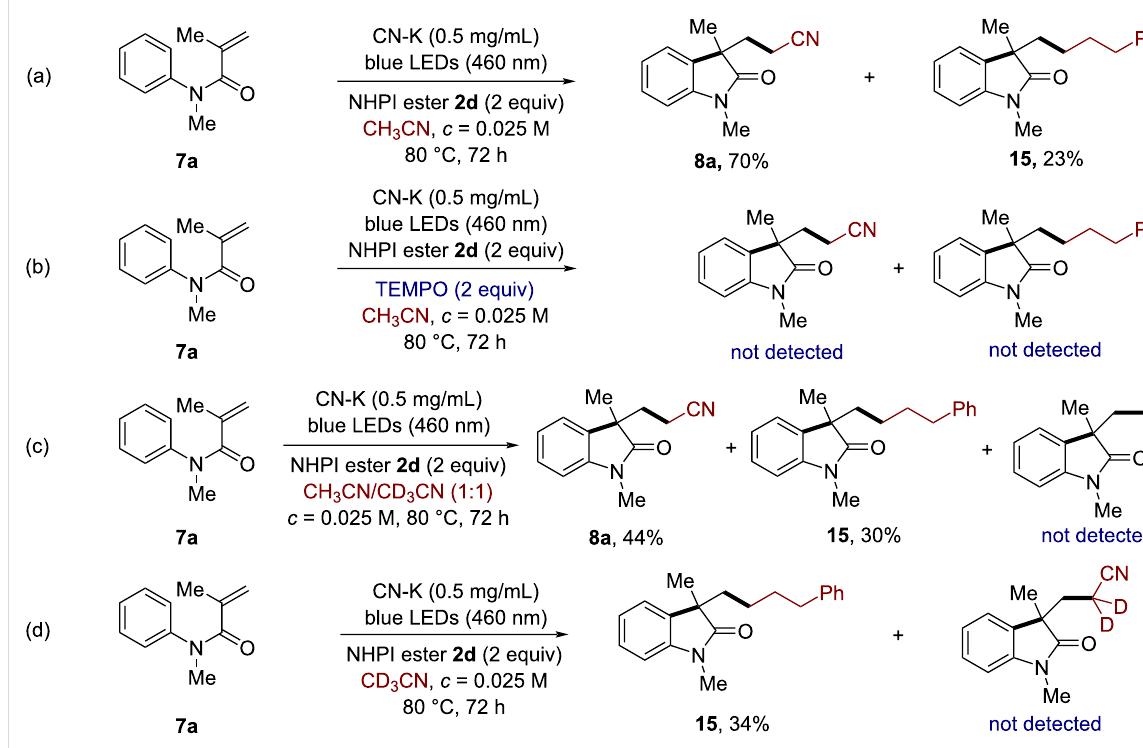
Scheme 7: Experiments for the mechanistic